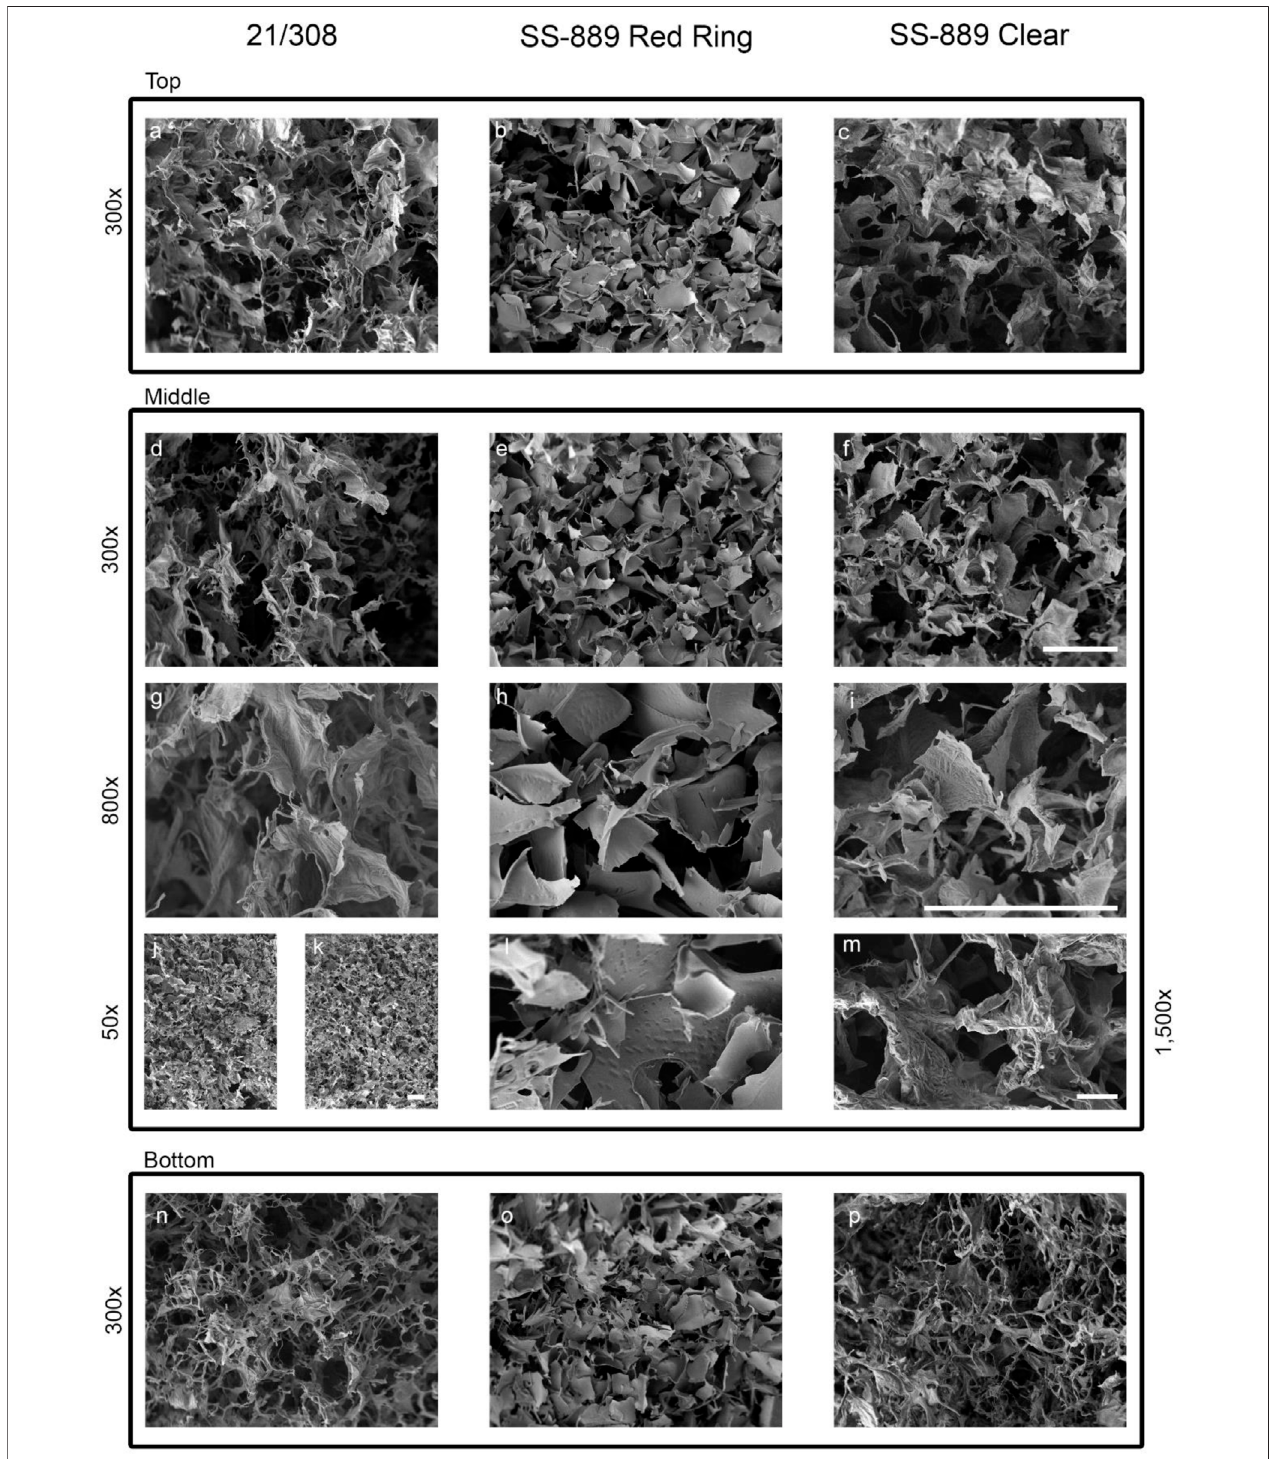
FIGURE7| High-resolutionSEMimagesoftheNaCl-containingde fi nitive(21/308)andthewithNaCl(SS-889clear)andwithoutNaCl(SS-889redring)trialfreeze- dried cakes. Images a-f and n-p show top, middle and bottom of the cakes at 300 × magniifcation. Images g-i show a highr magni fi ciation view at 800× of the middle sectionofthecakes.Imagesjtomshowlower×50(j,k)andhigher×1,500magni fi cations[(l,m),respectively]offormulationswithoutNaCl,(j)and(l)(SS-889redring),and with NaCl, (k) and (m) (SS-889 clear). Gradation scale = 100 µm in all panels.